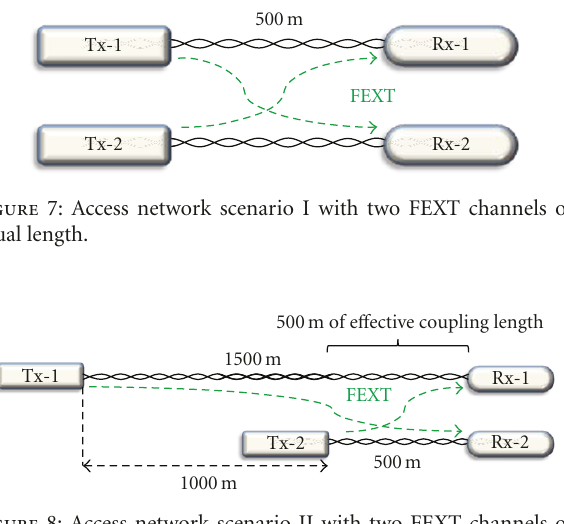
Figure 8: Access network scenario II with two FEXT channels of unequal